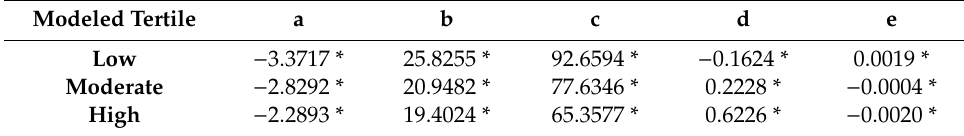
Table 2. Model Coe ffi cient Summary, with * representing significance at α = 0.01.